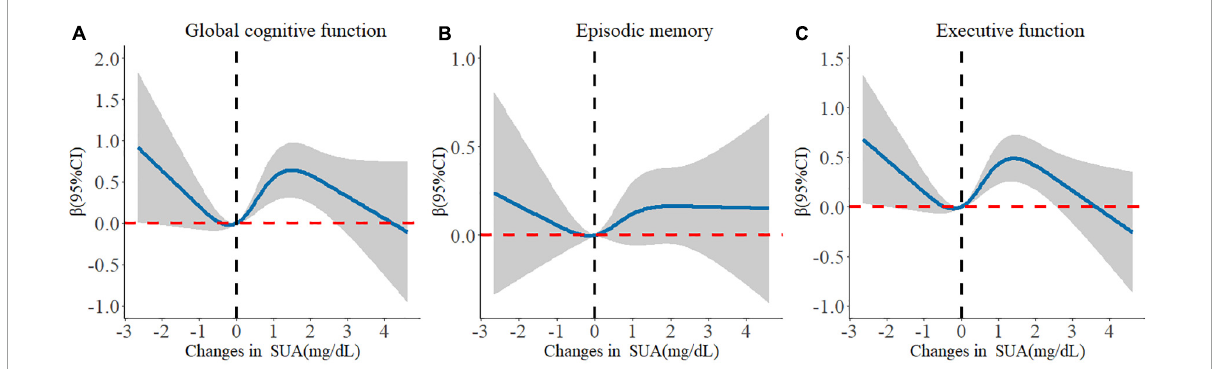
FIGURE3 Longitudinal dose-response relationship between changes in serum uric acid and cognitive changes. The curve was estimated by a restricted cubic spline function with four knots. Solid lines indicate the regression coefficient. The reference was set to 0 mg/dL. The shadow represents 95% confidence intervals. (A) Longitudinal dose–response relationship between changes in serum uric acid and global cognitive changes. (B) Longitudinal dose–response relationship between changes in serum uric acid and episodic memory changes. (C) Longitudinal dose–response relationship between changes in serum uric acid and executive function